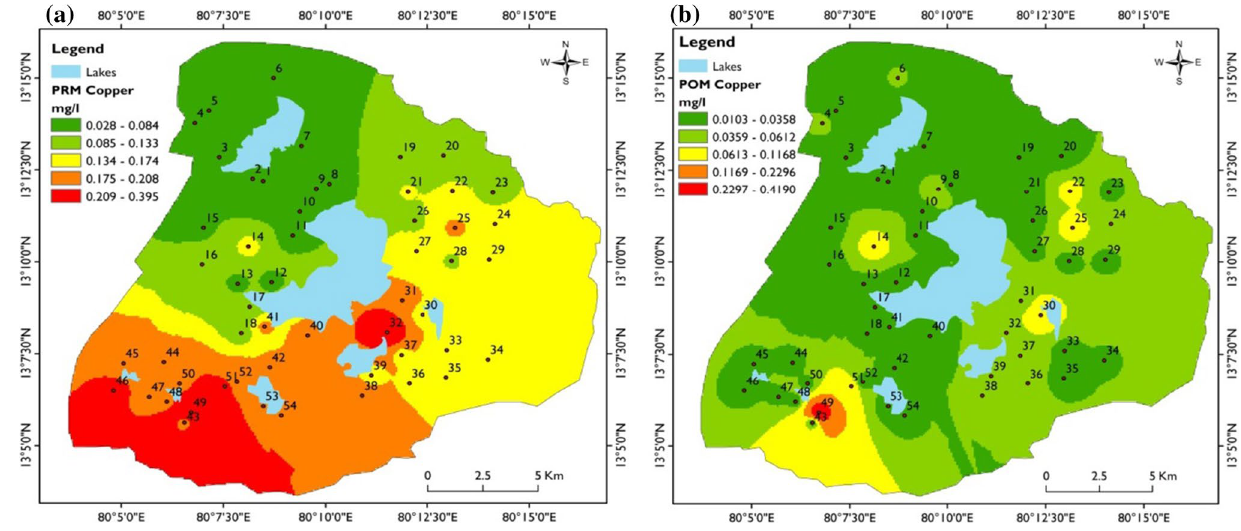
Fig. 5 a , b Spatial variation of Cu in the groundwater for pre-monsoon and post-monsoon,